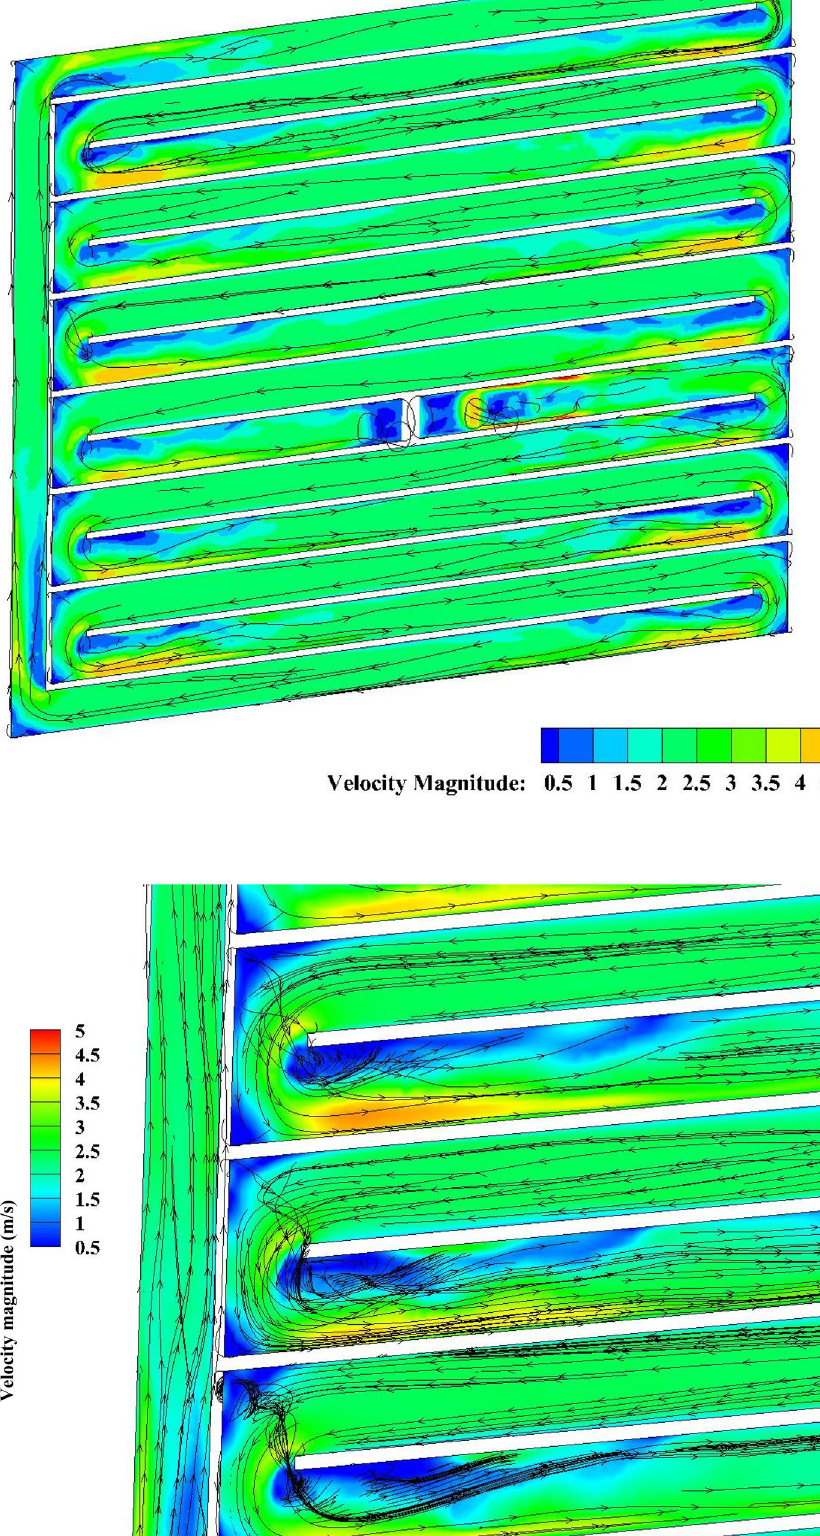
Fig. 25 Streamlines and veloc- ity contours on symmetrical plan at 10.047 kg/s